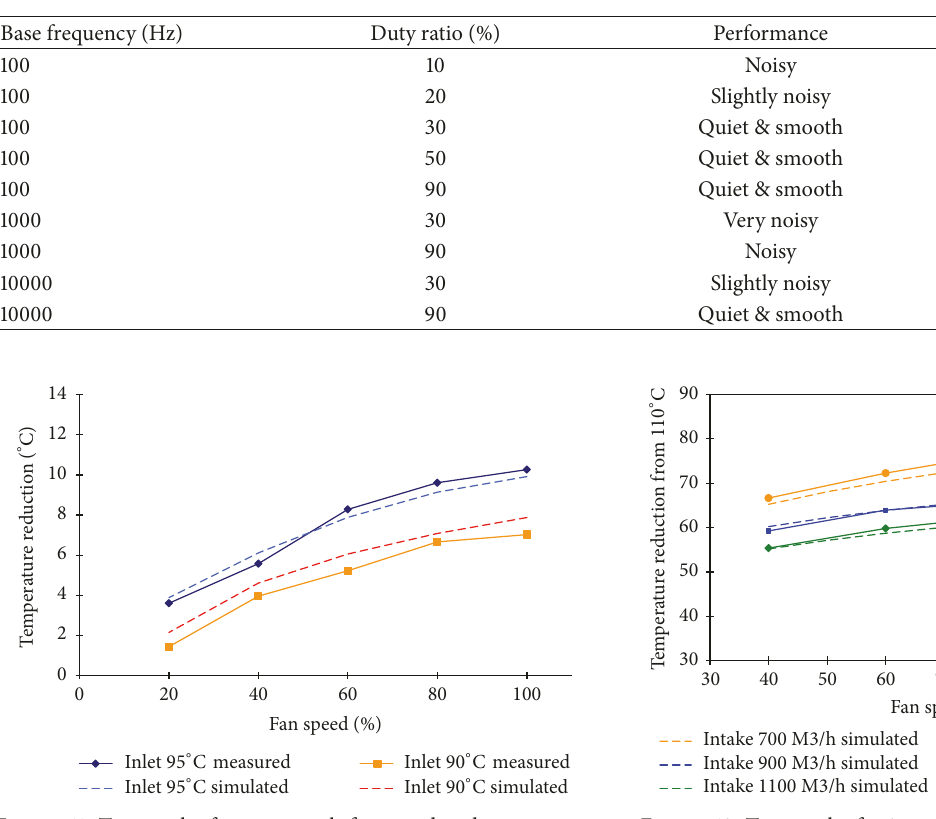
Figure 11: Test results for water tank fan speed and temperature reduction.